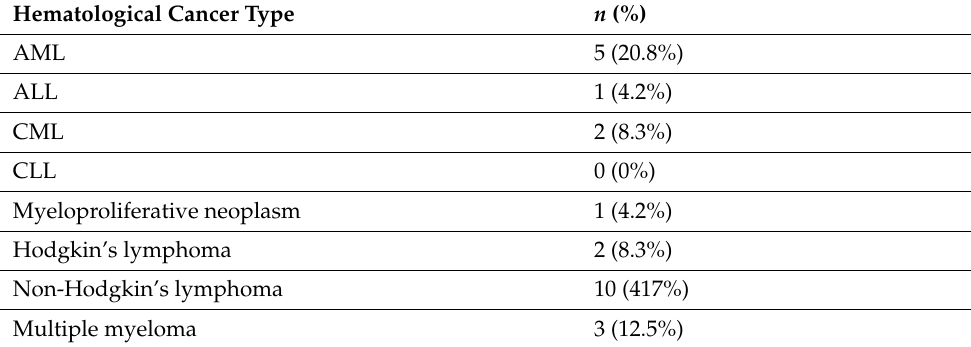
Table 3. Hematological cancer type ( n = 24). AML, acute myeloid leukemia; ALL, acute lymphoblastic leukemia; CML, chronic myeloid leukemia; CLL, chronic lymphocytic leukemia. Hematological Cancer Type